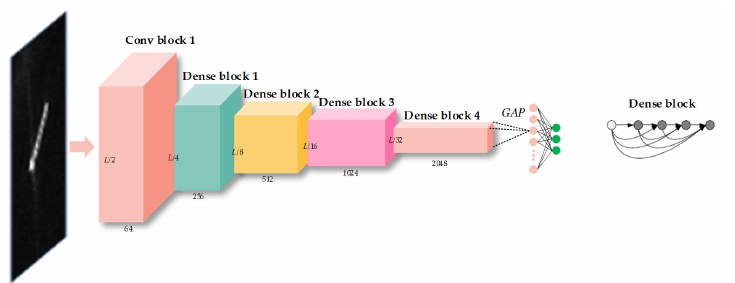
Figure 9. Network architecture of